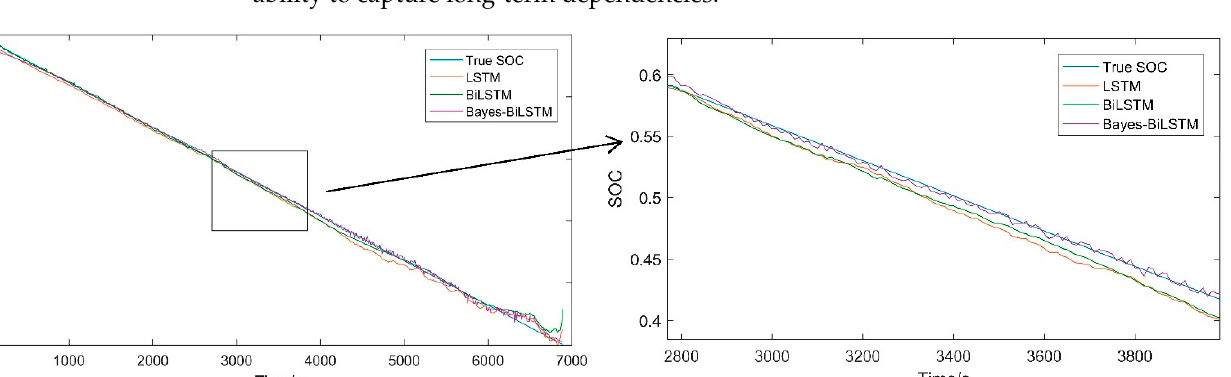
Table 6. Comparison of the estimation results of different methods.